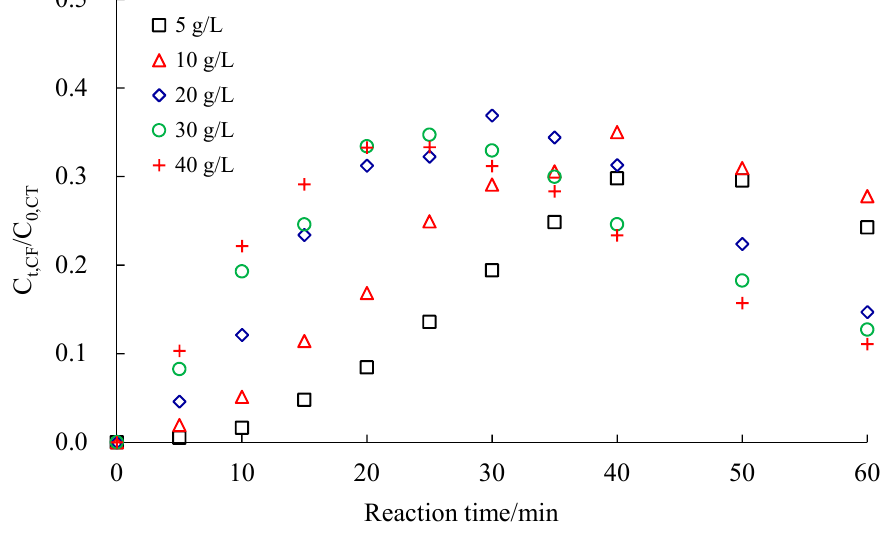
Figure 8. Changes in chloroform concentration with 0.4 wt.% Ag/Fe particles at different dosages. C 0,CT is the initial CCl 4 molar concentration, and C t,CF is the CHCl 3 molar concentration at time t.